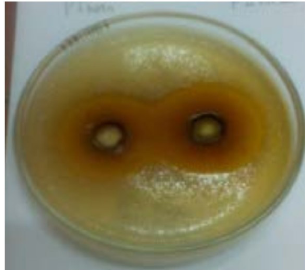
The clear zone on the left reffered to Peak I (PP) &PII (PP), and on the right reffered to Peak I (PP) &PII (EH) Fig. 8. The antimicrobial activity of a mixture of peak I and peak II for both extracts P. plebeium ( PP) and E. hirta , ( EH) against MRSA, B39